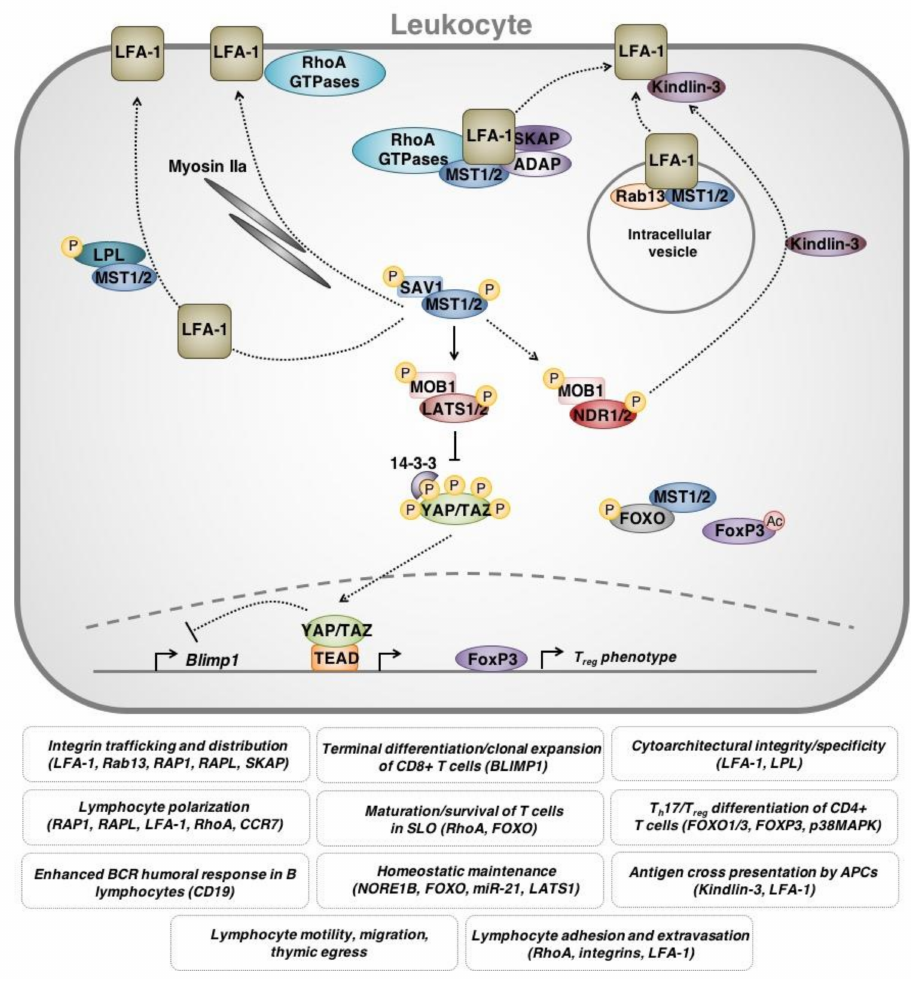
Figure 4. Overview of leukocyte-intrinsic Hippo pathway functions. Hippo pathway components are involved in regulating leukocyte activity, namely T lymphocytes. MST1 is also involved in both canonical and non-canonical signaling involved in T lymphocyte proliferation and survival. (1) MST1 plays a crucial role in regulating the cytoarchitecture of T lymphocytes to facilitate polarization, formation of the leading edge, adhesion and migration. This function is thought to be dependent upon the regulation of the integrin leukocyte function-associated antigen-1 (LFA-1). Direct and indirect interactions between MST1 and other proteins, including endosomal adaptor protein Rab13, cytoskeletal regulatory protein Kindlin-3, a number of RhoA GTPases (RAP-RAPL complex, Rac1), L-plastin (LPL) and myosin IIa all lead to proper LFA-1 activation, spatiotemporal distribution and appropriate low/high affinity partitioning on T lymphocyte membrane. These interactions allow for T lymphocyte migration, survival and adhesion, as well as enable correct thymic egress and secondary lymphoid organ infiltration. (2) MST1/2 signaling is also involved in CD4+ T lymphocyte T h 17 differentiation, through interactions with FOXO1/3 and upregulation of FoxP3 transcriptional activity. (3) Hippo signaling is also involved in regulating clonal expansion of CD8+ T lymphocytes vs. terminal differentiation, through transcriptional regulation of Blimp1. (4) Hippo signaling through LATS1 or MST/FOXO interactions is implicated in apoptotic control, homeostatic maintenance of T lymphocytes and control of oxidative stress. Solid lines represent direct interactions. Dotted lines represent mechanisms that are indirect or that have not been fully